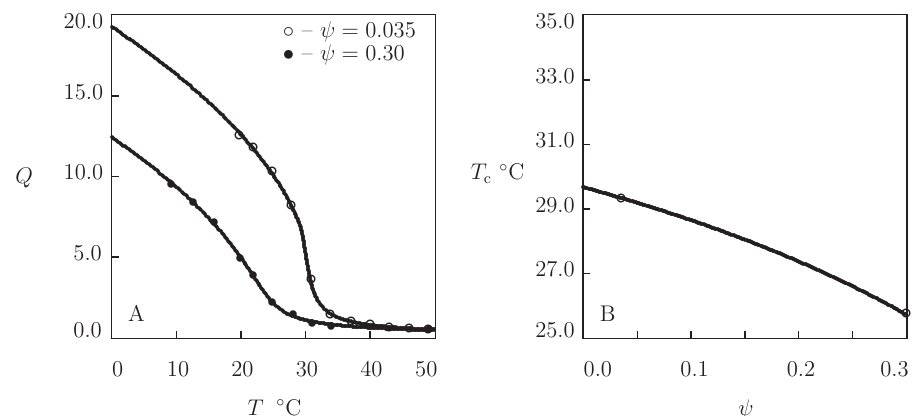
Figure 4. ( A ) Degree of swelling Q versus temperature T . Symbols: experimental data [56] on P(VCL-MEA) microgels with various molar fractions ψ of MEA monomers. Solid lines: results of simulation. ( B ) Volume phase transition temperature T c versus molar fraction of MEA monomers ψ . Circles: treatment of experimental data. Solid line: results of